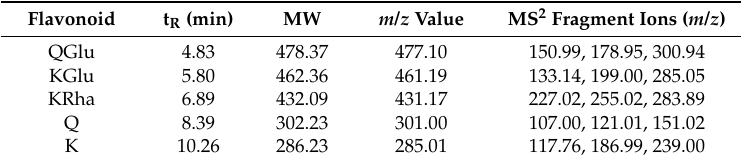
Table 2. Retention times, MWs, m / z values, and MS 2 fragmentation ions of the five flavonoids detected in C. paliurus leaves.